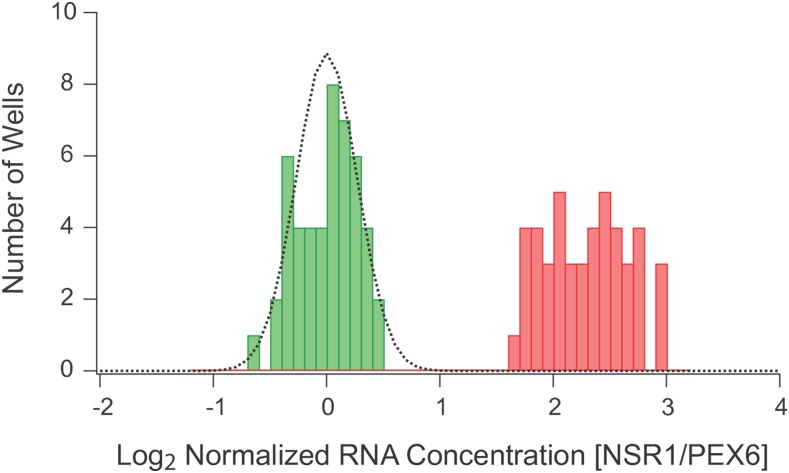
NSR1 expression levels during log growth and 0.4 M KCl stress. Histogram showing the distribution of NSR1/PEX6 expression ratios for wild-type cells grown on a single plate and then treated with 0.4 M KCl (48 samples, green) or mock stress (48 samples, red). The data were normalized (by adding a single constant to all 96 log NSR1/PEX6 ratios) so that the average signal in stress is 0.0. The dotted line shows the fit to a normal distribution with a standard deviation of 0.26 and an average of 0.0.